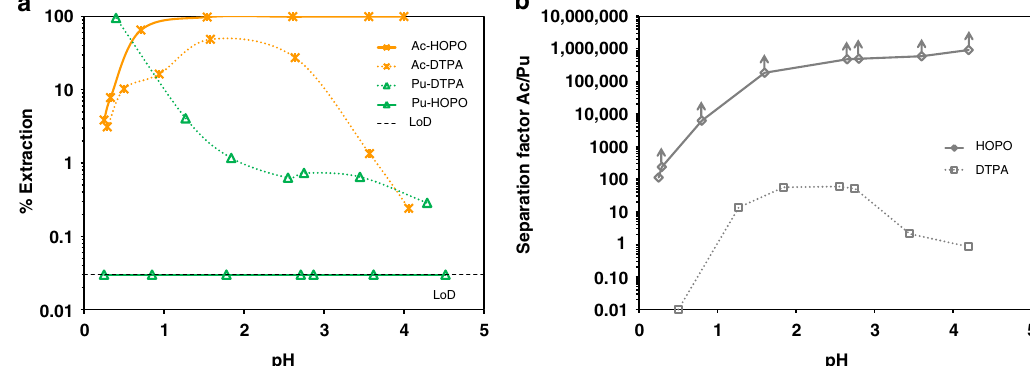
Fig. 2 Separation of Ac from Pu. a Extraction yield of Ac 3 + (stars) and Pu 4 + (triangles) by 0.5 M HDEHP as a function of pH, in the presence of DTPA (dotted lines) or 343HOPO (solid lines). A logarithmic scale is used due to the low extraction yields of Pu 4 + . b Corresponding separation factors. Aqueous phase: 40 mM of chelator in sodium lactate/sodium nitrate buffer ( I = 2 M). V org / V aq = 1. T = 25 °C. LoD = Limit of detection. Data points with arrows are